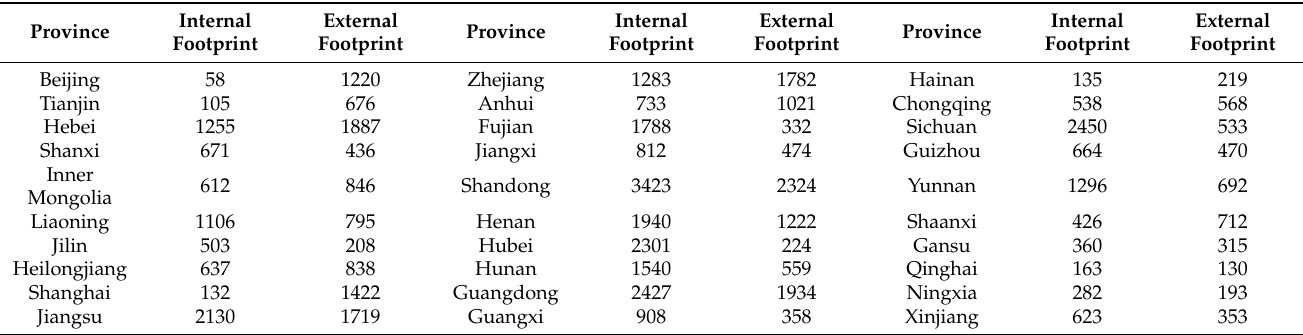
Table 5. Complete agricultural land footprint (10 4